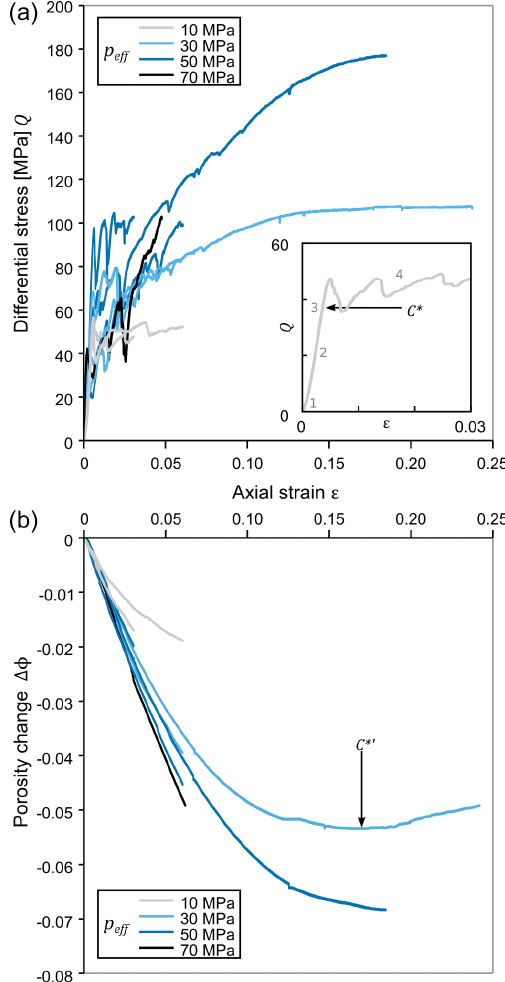
Figure 2. (a) Differential stress versus axial strain for all exper- iments. Inset shows a close-up of an experiment (sample LLB-7) highlighting different stages of deformation (refer to text for expla- nation). (b) Porosity change as a function of axial strain for all tests. Effective pressure at which deformation was performed is indicated by the line